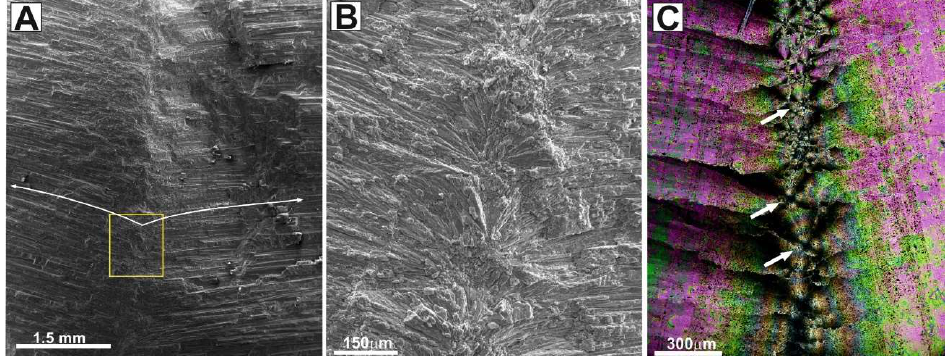
Figure 6. Photographs showing spherulites developed along the apical line in belemnite rostra. ( A ) SEM images of longitudinal fresh cut sample showing the apical line and the area where spherulites are observed (specimen PC-39). White arrows indicate the sense of crystal growing from the apical line. ( B ) Detail of A showing the spherulites. They are composed of radially arranged calcite crystals. Crystals become progressively longer and prismatic towards the external walls of the rostrum ( A ). ( C ) Ultra-thin section observed under PL microscopy (PC-31-04). Spherulites are observed along the apical line (white arrows). Note that prismatic crystals traverse the concentric growth layering and display micro-fibrous texture and undulose extinction.